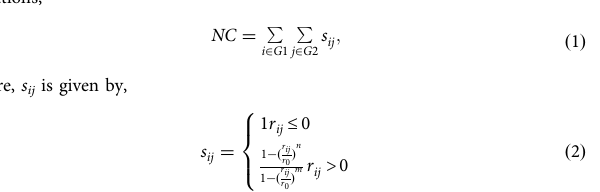
Fig. 5 PPEF or BPVF show fast accumulation and inhibition of bio fi lm formation. a The accumulation assay of PPEF or BPVF in E. coli K12 (MG1655), Δ yciM (MG1655) , lpxC (MG1655), and lpxD (MG1655) strains. Data were presented as the mean of three independent experiments with four replicates. b The accumulation assay graph of PPEF or BPVF treatment in S. aureus (ATCC 25923) and A. baumannii (W704). Data were presented as the mean of three independent experiments with four replicates. c The ef fl ux assay graph of PPEF or BPVF treatment in E. coli K12 (MG1655), Δ yciM, lpxC , and lpxD . Data were presented as the average of three independent experiments with four replicates. d The ef fl ux assay graph of PPEF or BPVF treatment in S. aureus (ATCC 25923) and A. baumannii (W704). Data were presented as the mean of three independent experiments with four replicates. e , f Bio fi lm